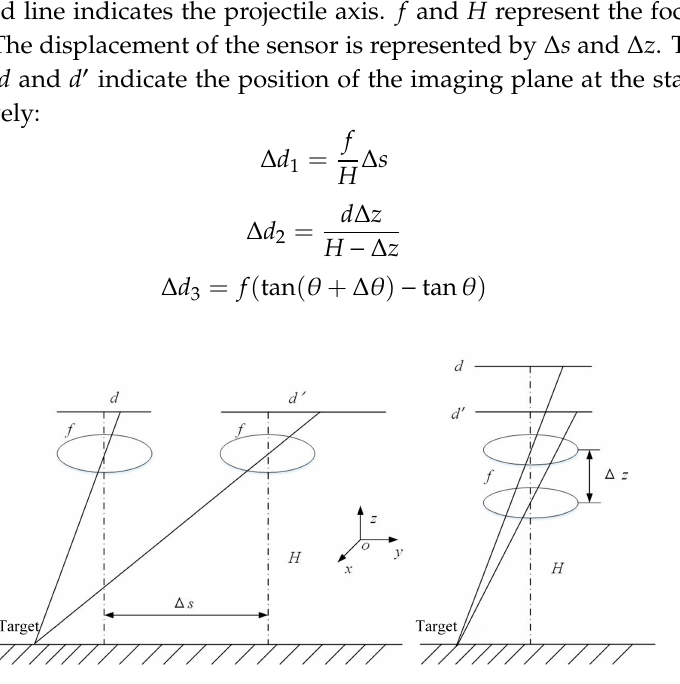
Figure 5. Pixel movement caused by shakiness. 3. Electronic Video Stabilization When there are moving dim objects in the scene, the traditional gray projection algorithm will reduce the accuracy of the global motion vector estimation due to the calculation of the sum of all gray values. In this section, the image is divided into blocks and quickly filtered to maintain the accuracy of the global motion estimation without increasing the computational cost. 3.1. AGGT The difference between infrared image and RGB image is that the infrared image’s background area has a low contrast, which has a serious effect to the estimation of global motion vectors during the image stabilization. Therefore, the adaptive histogram equalization method can increase the contrast of the background of the infrared image to highlight the difference of gray level. In addition, the image was divided into sub-blocks which were used to estimate global motion vectors. It should be noted that the number, size and density of the sub-blocks directly affected the accuracy and computation of the global motion estimation. The amount of pixel movement leading by the shakiness of the projectile should not exceed the size of the block, and the relationship between them can be calculated by Equation (6). The sub-blocks were arranged according to the array. Then, the even numbered blocks were taken for each row and column, so as to avoid double counting the same area and reduce the number of pixels which needed to be calculated by four times in theory: 𝑐𝑜𝑙 (cid:3038) (cid:4666)𝑗(cid:4667) = (cid:3533) 𝐺 (cid:3038) (cid:4666)𝑖, 𝑗(cid:4667) (cid:3041) (cid:3037)(cid:2880)(cid:2869)